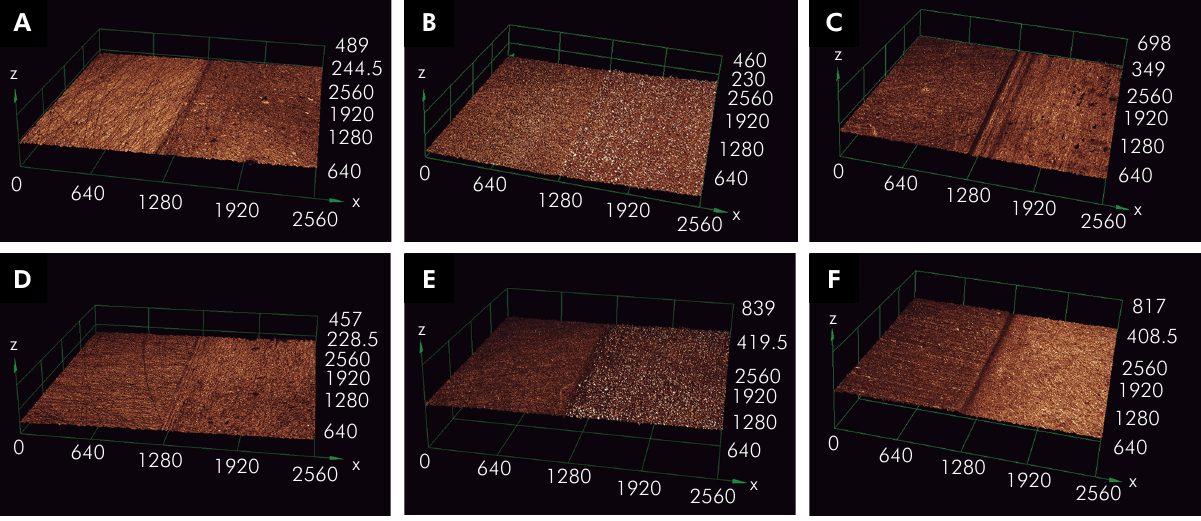
Figure 2. Three-dimensional confocal images showing the unbrushed/control (left side) and brushed (right side) areas of bulk-fill composites (A- FBF, B- SDR, and C- TET polymerized with the Valo, and D- FBF, E- SDR, and F- TET polymerized with the Demi Ultra).